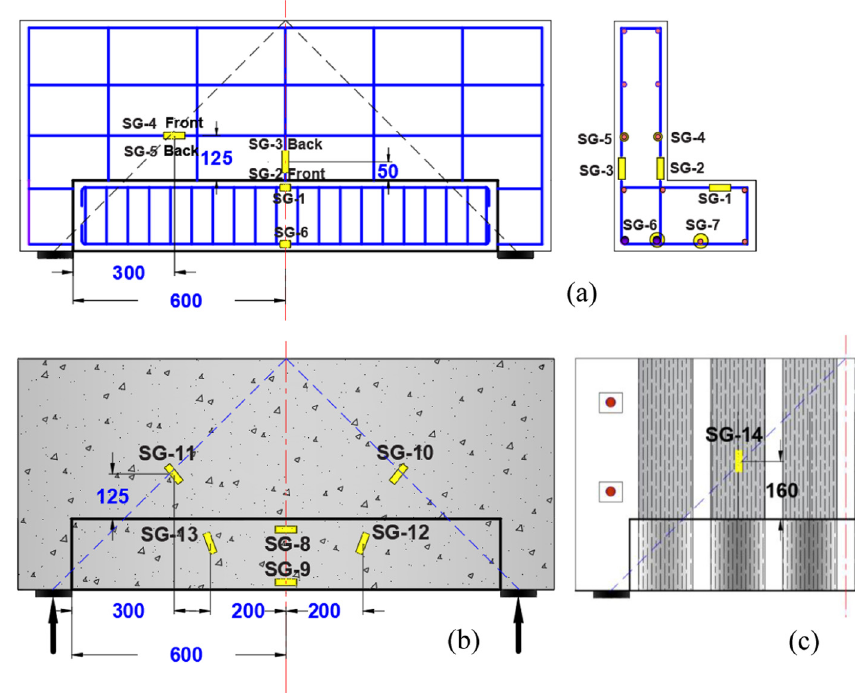
Figure 8: Strain gauges location on ( a ) rebars, ( b ) concrete, and ( c ) CFRP sheet.